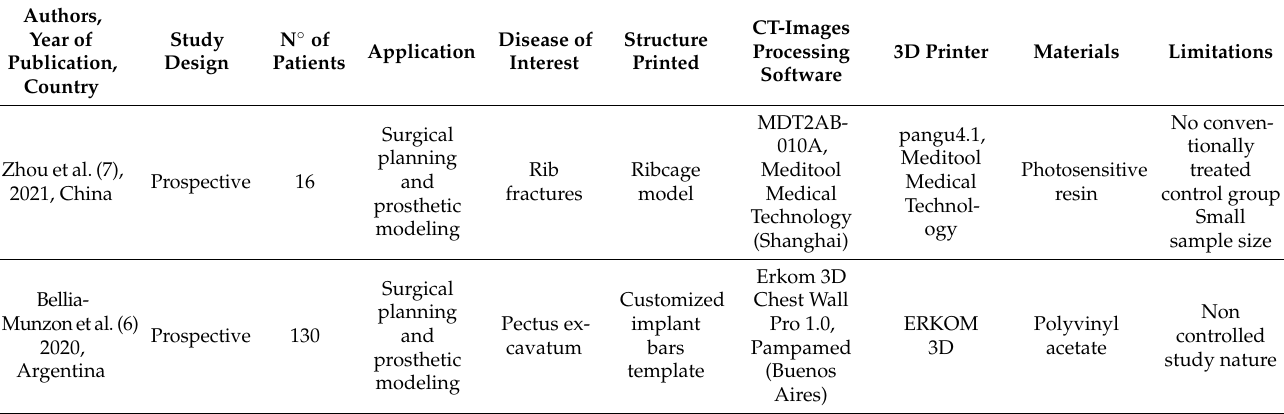
Table 3. Characteristics of the studies